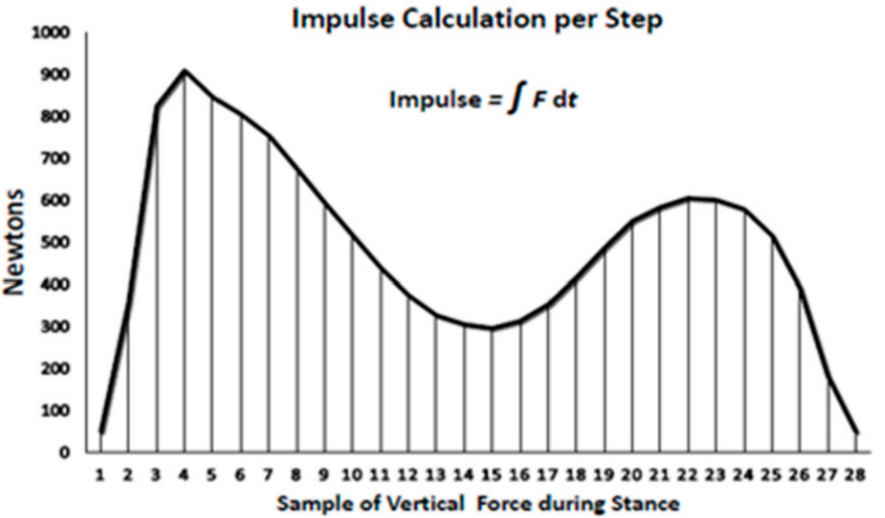
Figure 1. Calculation of impulse or force–time integral per step.